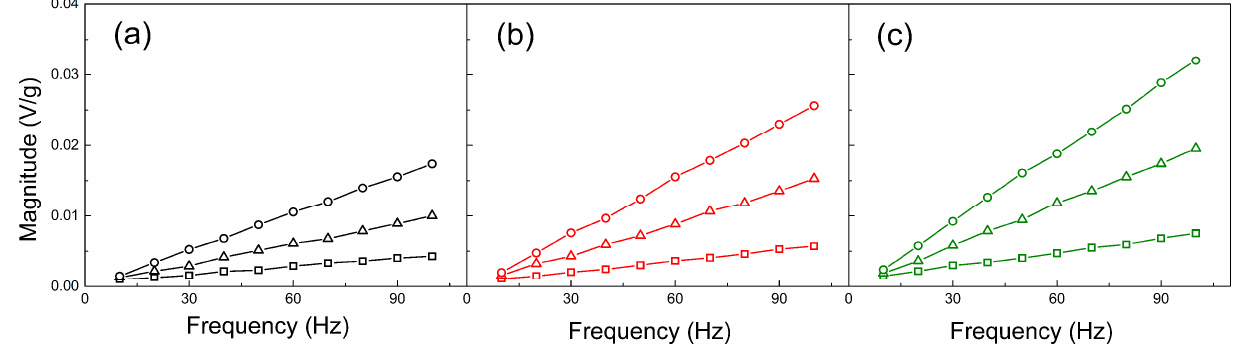
Figure 12. Vibration sensing measurements of neat PVDF (black) ( a ) and composites containing PVDF/GO (red) ( b ) and PVDF/GO-PBA particles (green) ( c ) at various frequencies and resistances—10 k Ω (squares), 30 k Ω (triangles) and 50 k Ω (circles).